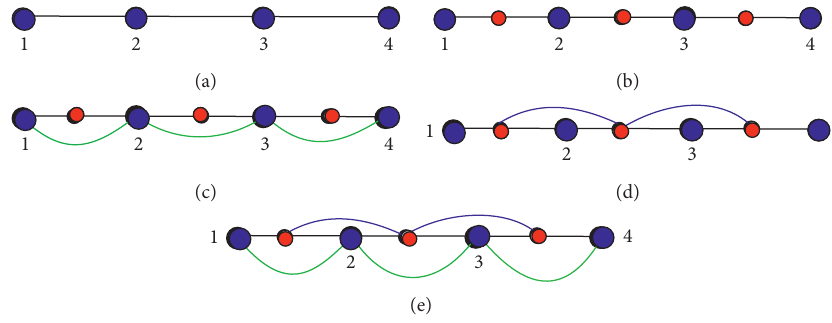
Figure 1: (a) G � P , (b) S ( G ) , (c) R ( G ) , (d) Q ( G ) , and (e) T ( G ) 4